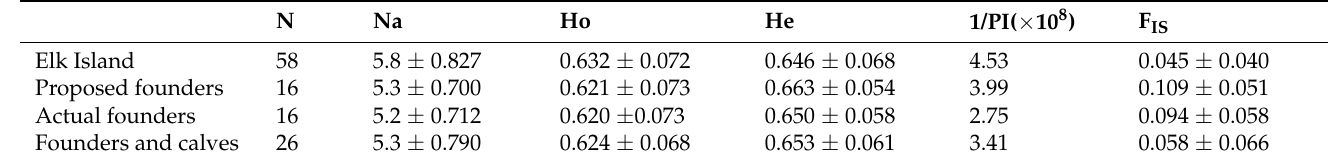
Table 3. Genetic diversity in Banff NP proposed founders, actual founders, and founders and calves as compared to the source herd in Elk Island. N, number of individuals, Na, mean number of alleles, Ho, observed homozygosity, He, expected heterozygosity, PI, probability of identity. Ho He 1/PI( × 10 8 ) F